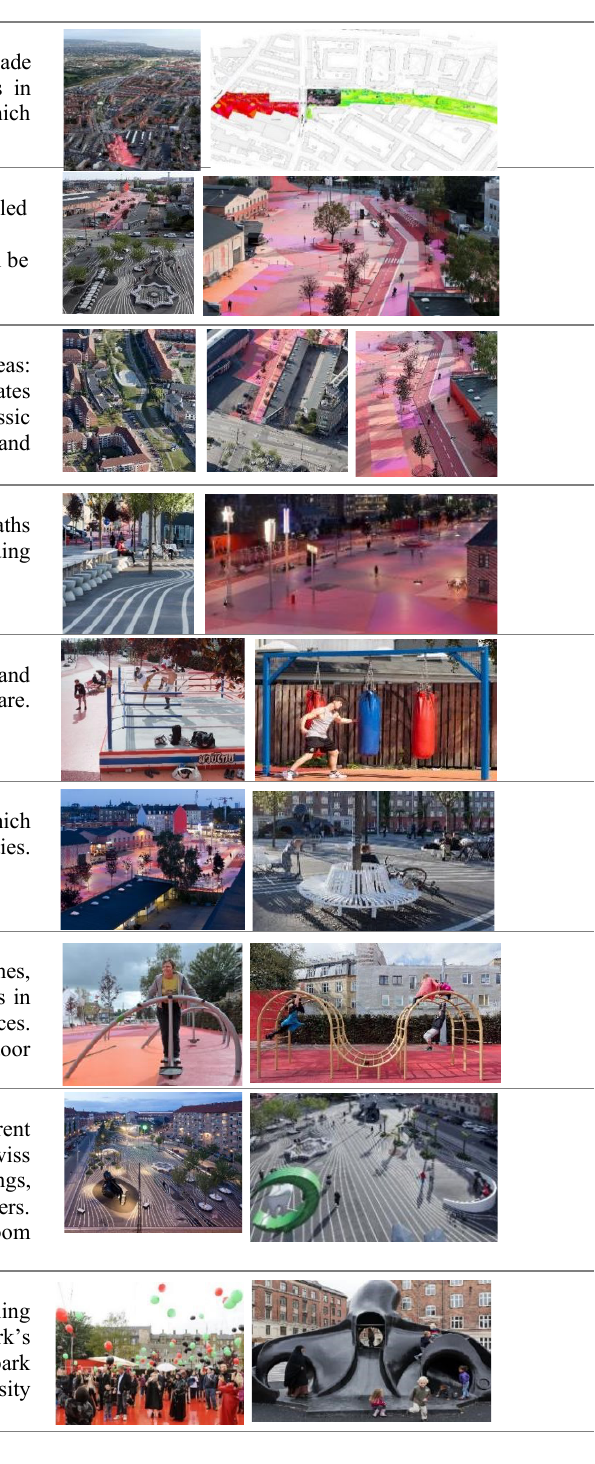
Table 3 : Selection of the most prominent Functional elements in "Superkilen" (analyzed by the authors) (Figures source: URL5) Functional Elements (Defined and selected by